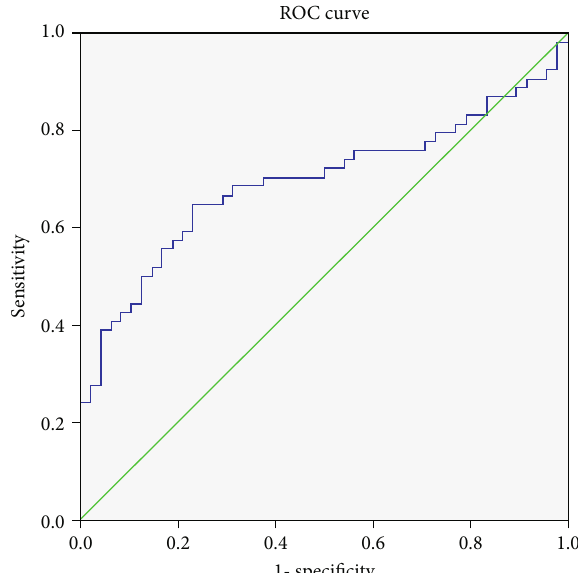
Figure 1: ROC curve of preoperative NMP22 conveying in assessing the postoperative recurrence of bladder